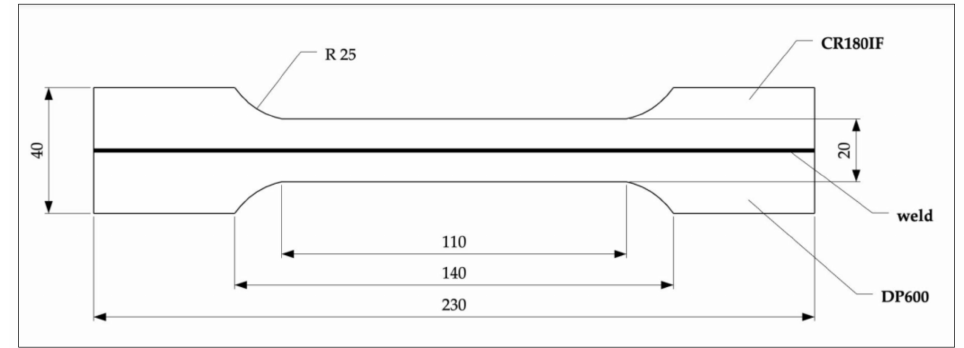
Figure 2. Specimens for tensile test, laser-welded specimen (unit: mm).